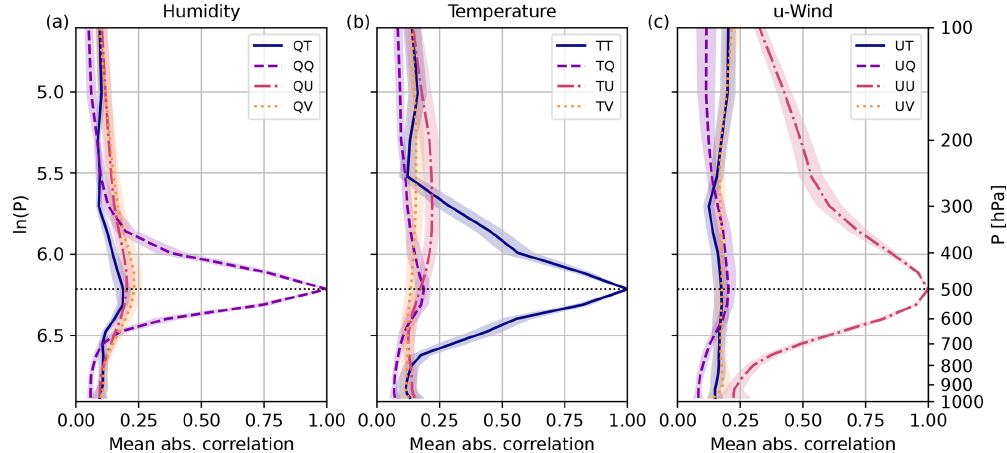
Figure 2. Domain-averaged absolute 1000-member (true) vertical correlations for reference level 500hPa and different variable pairs. (a) Hu- midity. (b) Temperature. (c) u -wind. Mean and standard deviation over 10 forecasts from 29 May to 2 June 2016.